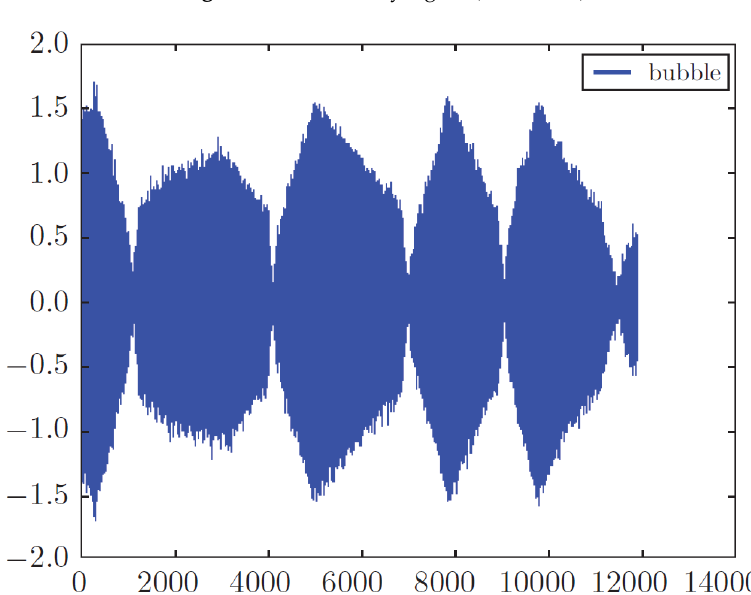
Figure 8. Raw healthy signal (no bubble).